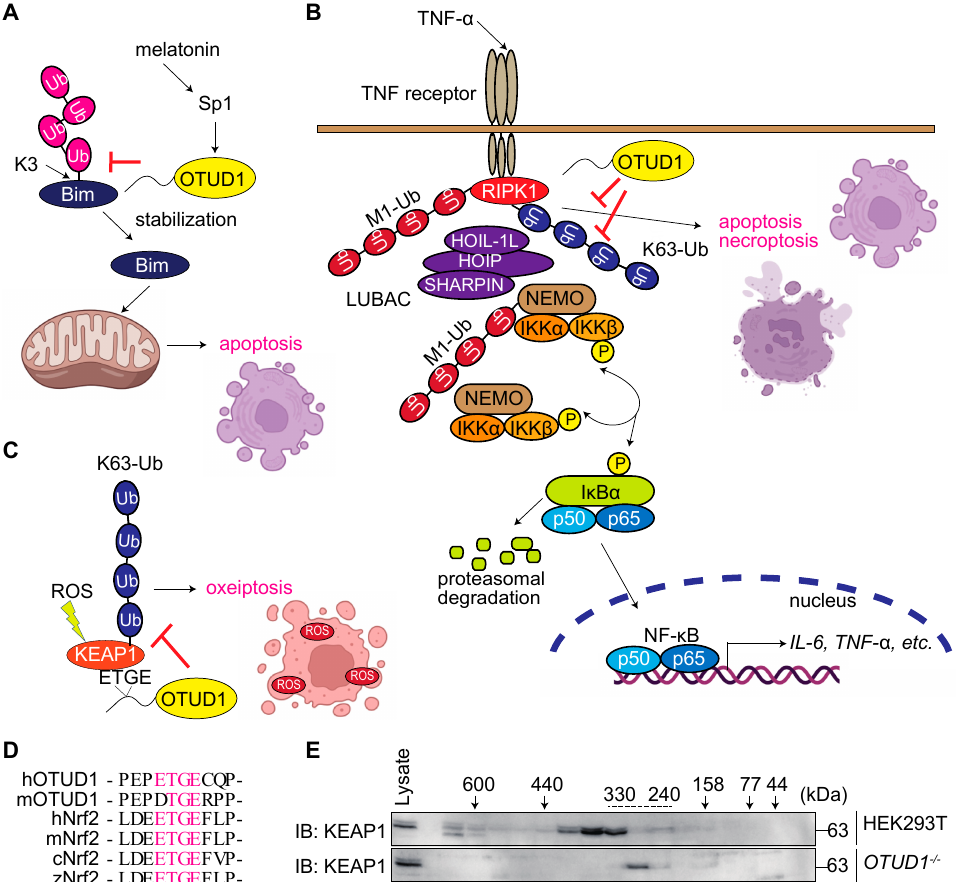
Figure 5. OTUD1 regulates cell death pathways. ( A ) OTUD1 stabilizes Bim and induces apoptosis [49]. ( B ) OTUD1 suppresses the canonical NF- κ B and TNF- α -induced apoptosis and necroptosis pathways by cleaving the K63-linked ubiquitin chain [19]. ( C ) OTUD1 binds KEAP1 through the ETGE motif in the APGR of OTUD1. ( D ) The amino acid sequence alignment of ETGE motifs in OTUD1 and Nrf2. h: human, m: mouse, c: chicken, z: zebrafish. ( E ) OTUD1 deficiency affects the intracellular